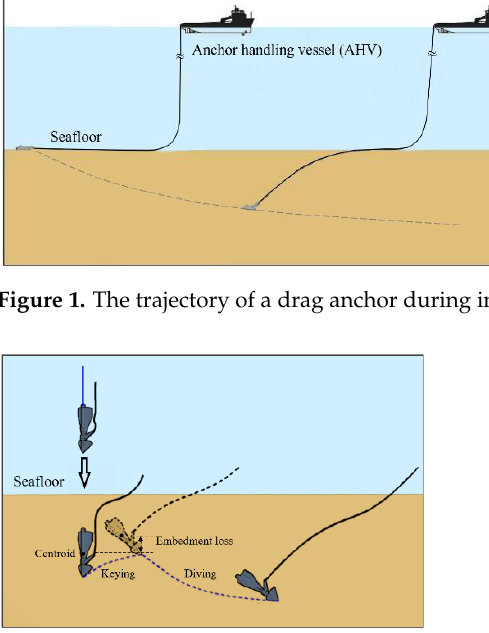
Figure 2. Installation, keying, embedment loss, and diving of a GIA [1].